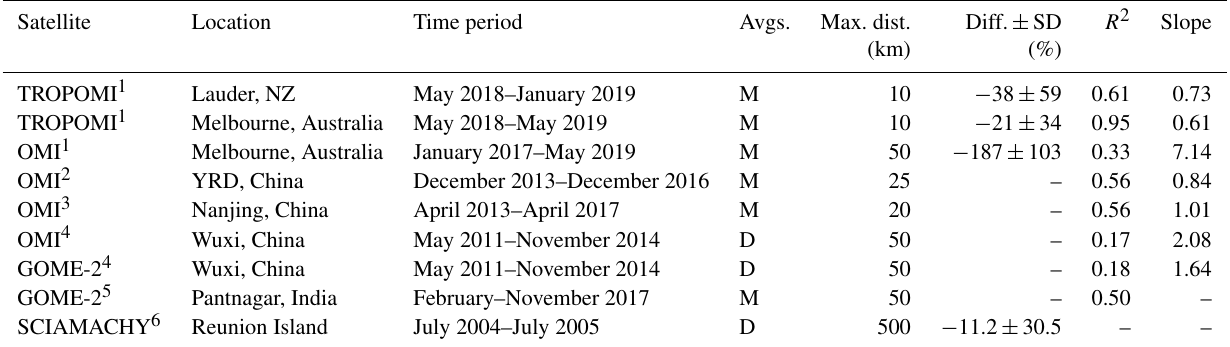
Table A1. Results from this and previous literature studies comparing formaldehyde vertical columns from MAX-DOAS and satellite re- trievals. Note that “Diff.” represents MAX-DOAS − satellite. Slope is the gradient ( m ) of the linear regression for Satellite = m × MAX- DOAS + C .